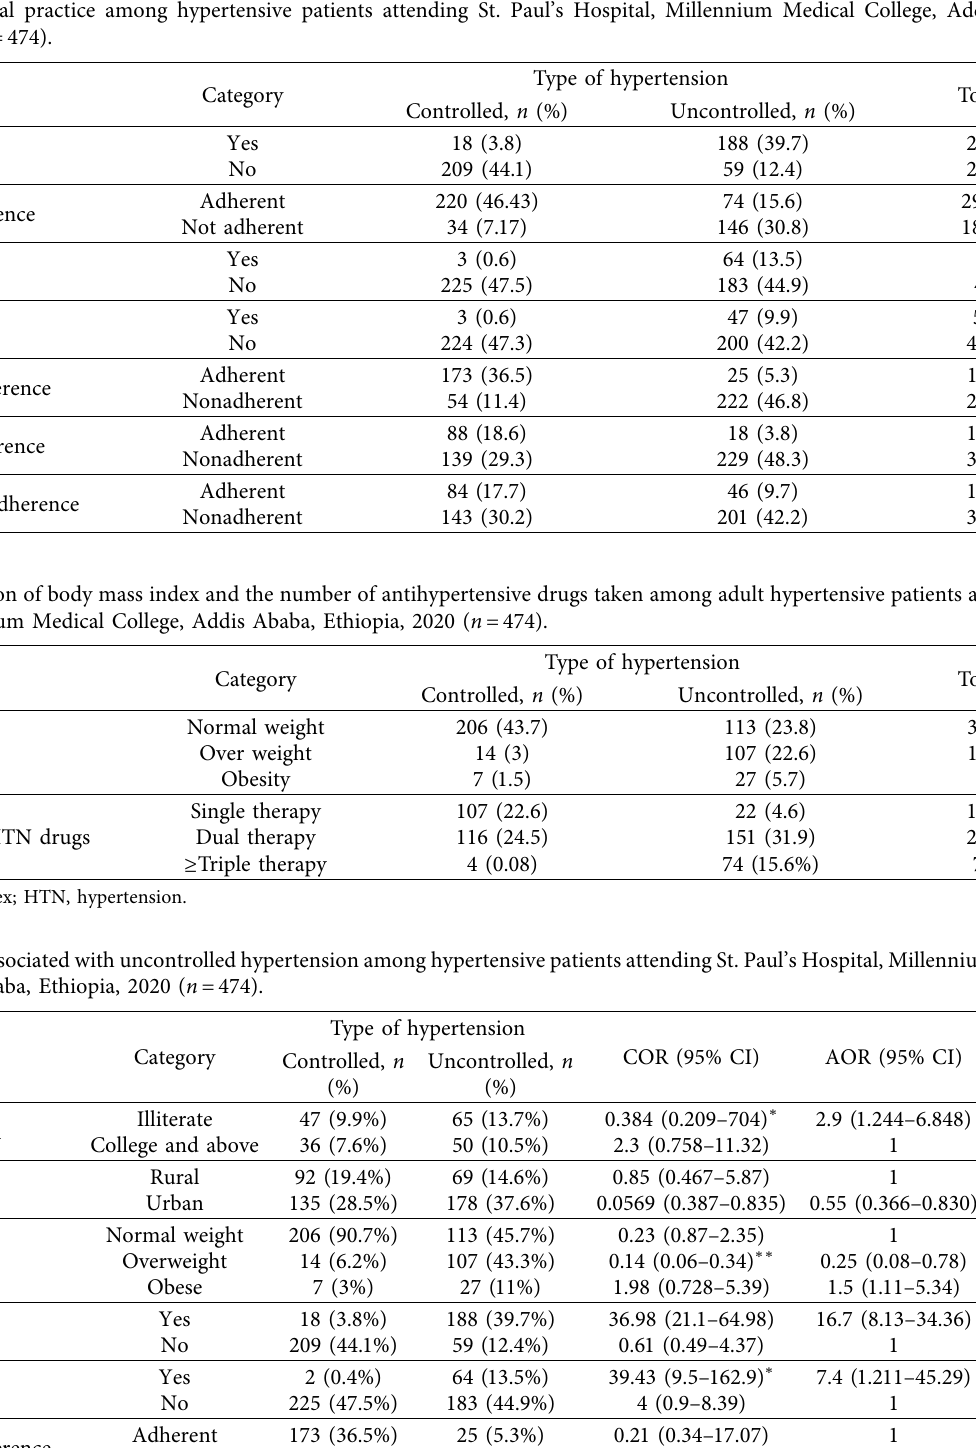
Table 2: Behavioral practice among hypertensive patients attending St. Paul’s Hospital, Millennium Medical College, Addis Ababa,